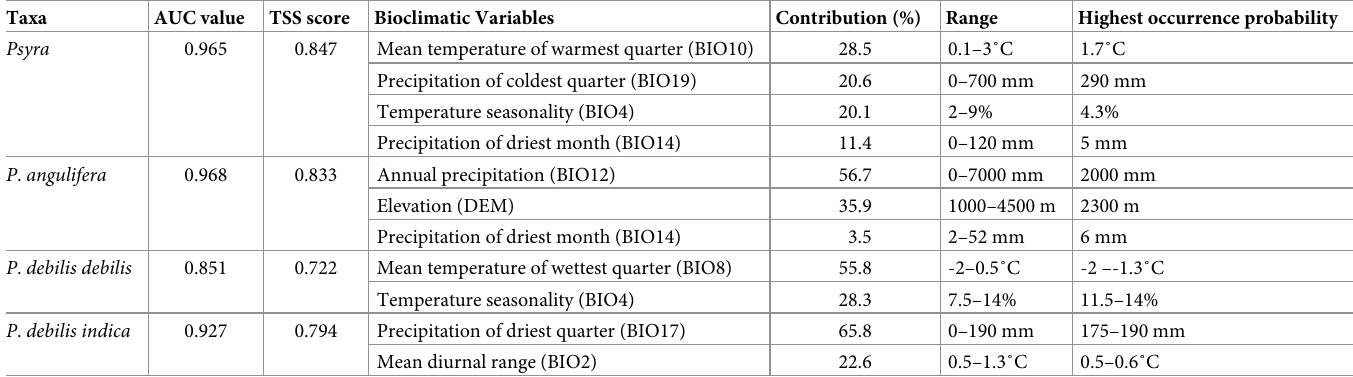
Table 2. Area under Curve (AUC) values and True Skill Statistics (TSS) scores of MaxEnt species distribution models generated for Psyra genus and 3 selected taxa P . angulifera , P . debilis debilis , P debilis indica along with relative contribution (%) of the significant bioclimatic variables, their range and values at which the occur- rence probability of the taxa was highest.